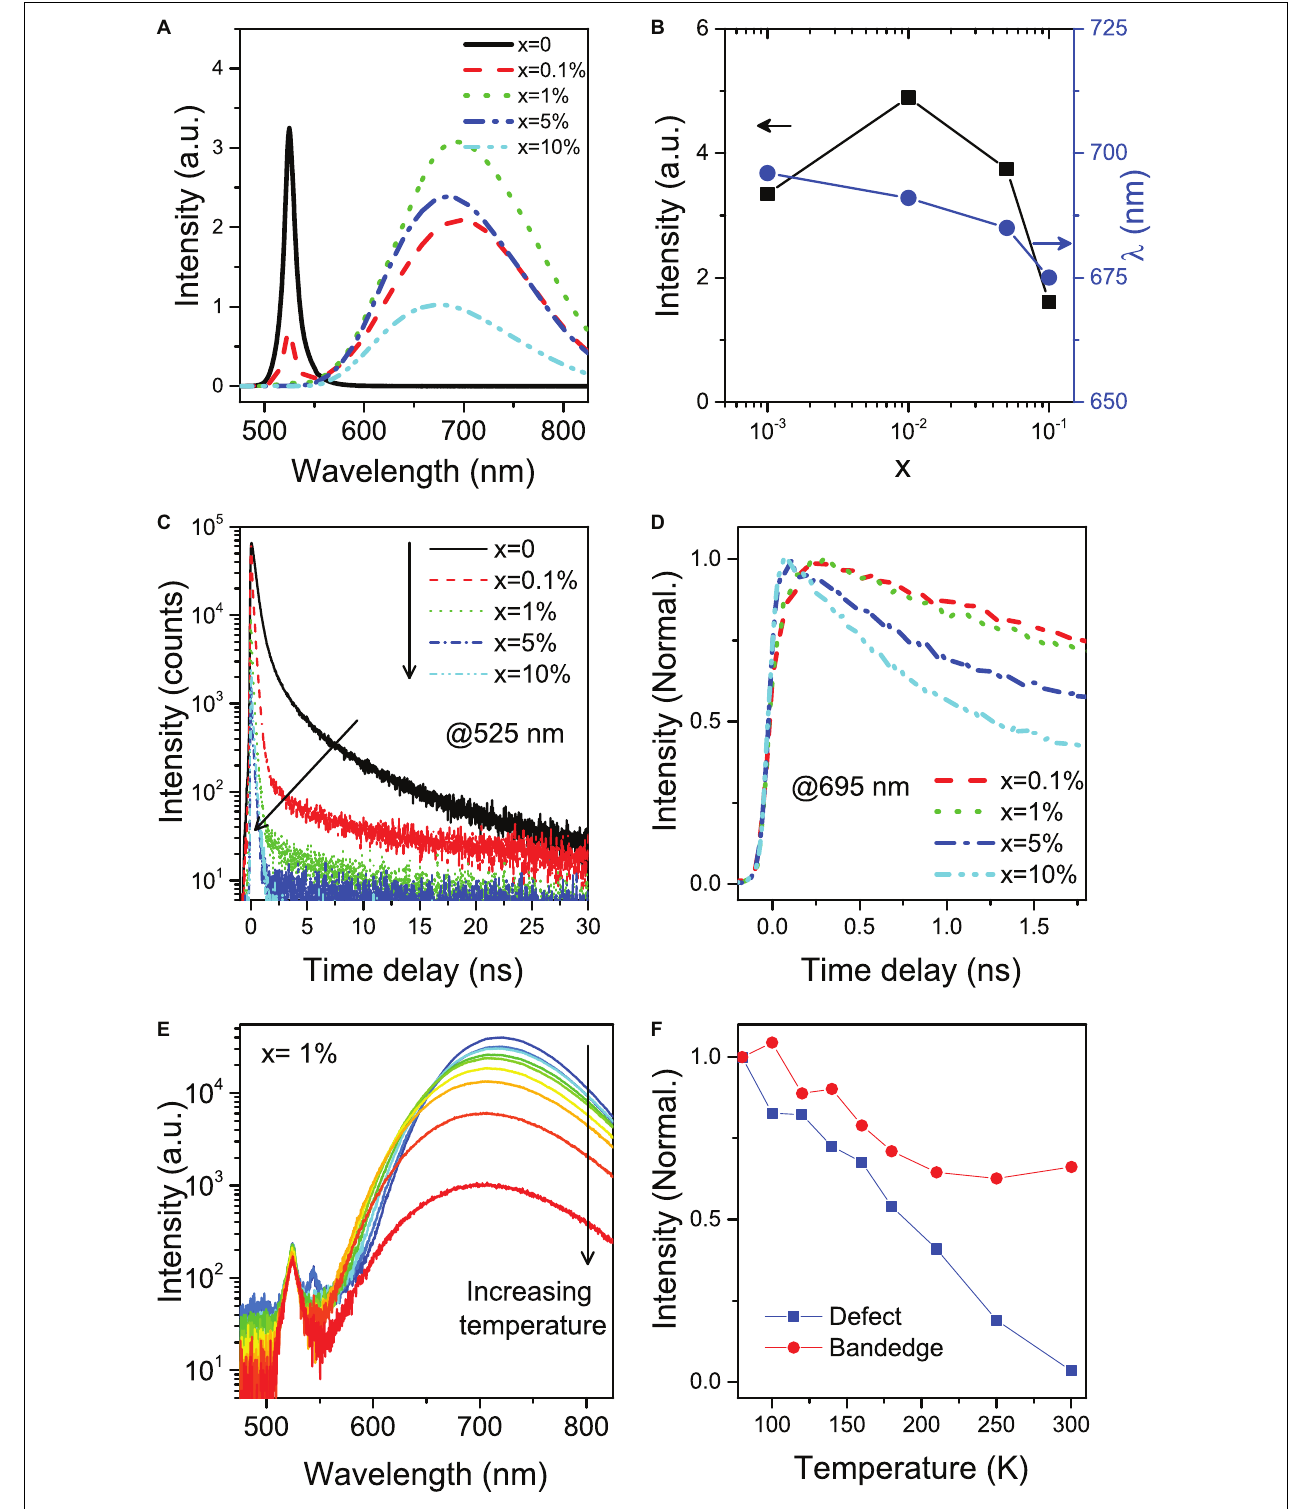
FIGURE 4 | PL emission from Sn-doped PEA 2 PbI 4 perovskites. (A) PL spectra from the samples with different doping levels at room temperature. (B) The emission intensities and peak wavelengths of the broadband emissions recorded from the samples with different doping levels. PL decay curves of the samples probed at 525 nm (C) and 695 nm (D) , respectively. (E) PL spectra recorded from an 1% Sn-doped sample. (F) Temperature-dependent intensities of emission at 525 and 695 nm plotted normalized to the values at 80 K.